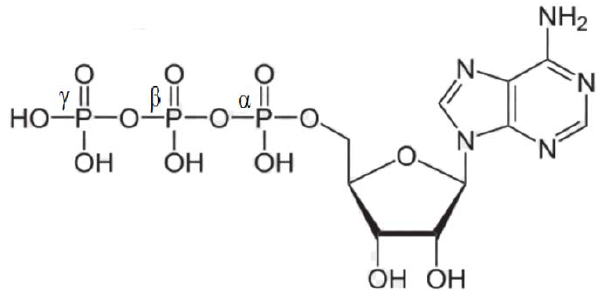
Figure 1. Schematic representation of the protonated form of